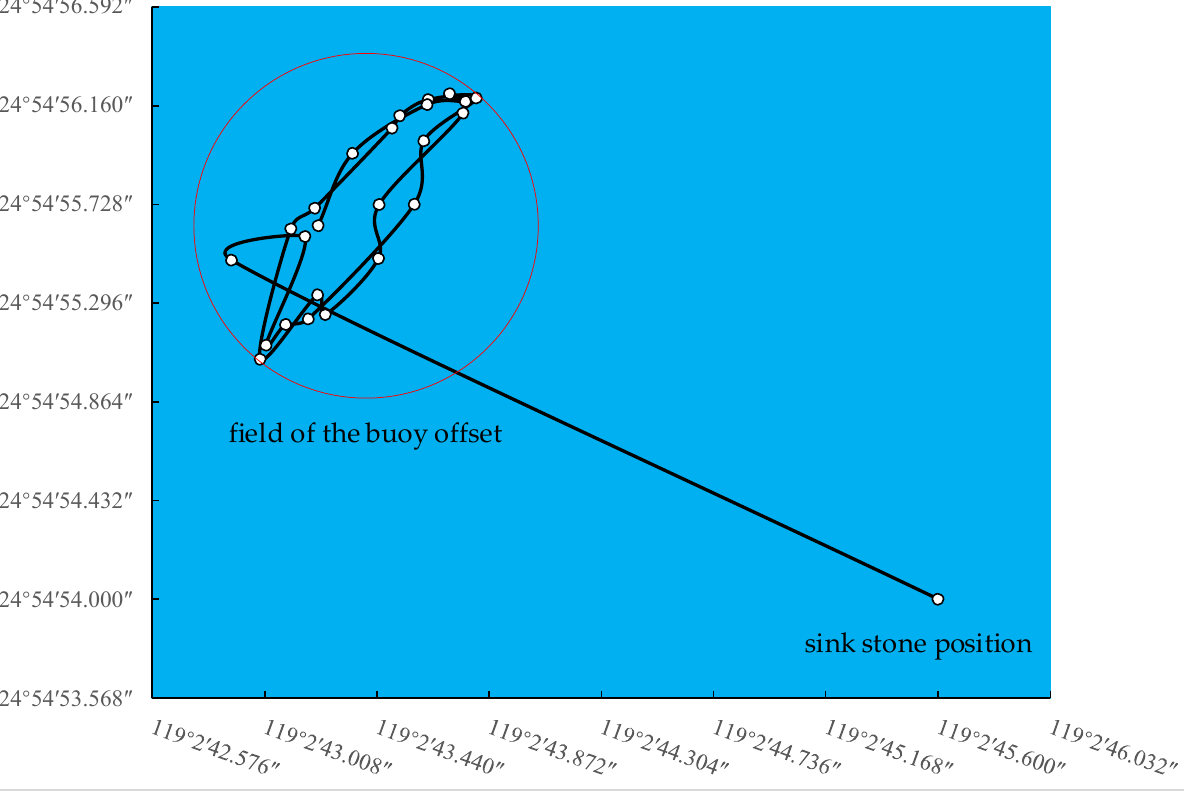
Figure 21. Field of Meizhou bay No.1 buoy offset. Taking Minyuhui 11512, Minyuhui 01,366 and Meizhou Bay 1 # buoy as simulation objects, the circular ship domain # 1, circular ship domain # 2 and buoy offset domain # 1 are constructed, respectively. The simulation results are shown in Figure 22. When the navigation parameter t = 100 s, Minyuhui 11,512 is 0.065 nautical miles from the center of the buoy field, with a heading of 65 ◦ , there is a risk of collision, and the collision avoidance angle is 22 ◦ . Minyuhui 01,366 is 0.058 nautical miles from the buoy field center, heading 270 ◦ , with no risk of collision, and no need to change direction. When the navigation parameter t = 2200 s, Minyuhui 11,512 is 0.037 nautical miles from the center of the buoy, with a heading of 43 ◦ , and the absolute difference between the actual route and the planned route is greater than 1 ◦ . Therefore, it is necessary to perform re-navigation, and the re-navigation angle is 47 ◦ . Minyuhui 01,366 is more